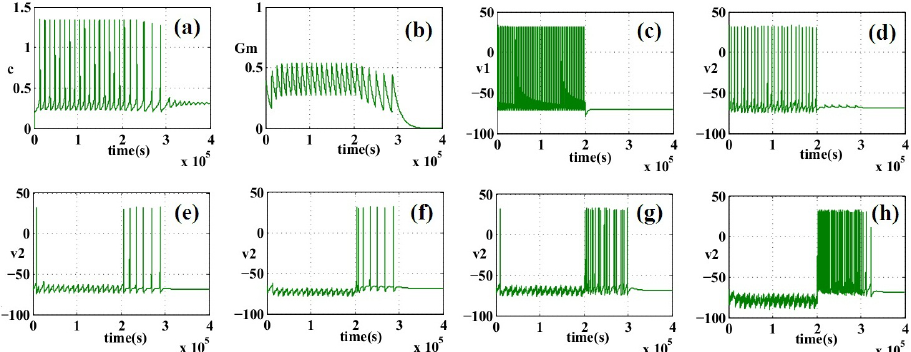
Figure 8. Closed-loop behaviour in the neural–glial interaction. ( a ) Calcium dynamic. ( b ) Astrocyte mediator (glutamate). ( c ) Spiking activity of pre-synaptic neuron. ( d – j ) Spiking activity of post- synaptic neuron based on different values of δ . By increasing δ , the intensity of neural activity is decreased and the spiking activity is controlled.